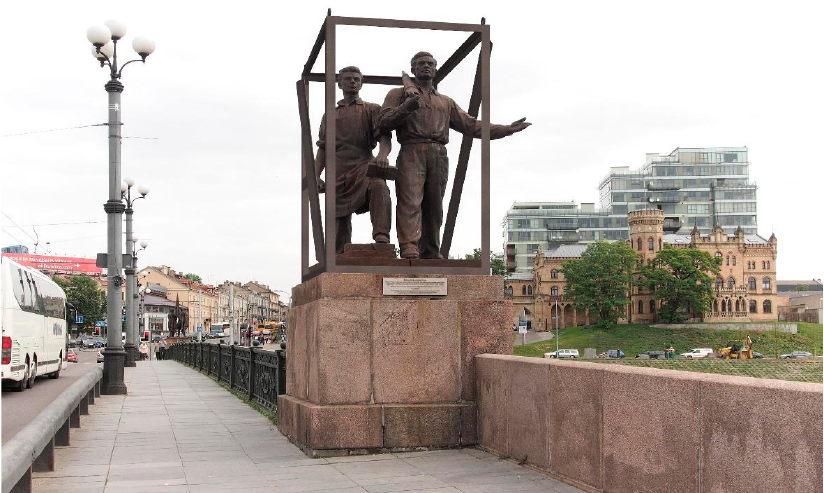
Figure 2. Symbolic imprisonment of Soviet sculptures in metal cages (designed by A. Ambrasas, 2014) on the Green bridge in Vilnius (architect V. Anikinas, 1948–1952). From the personal archive of A. Ambrasas.